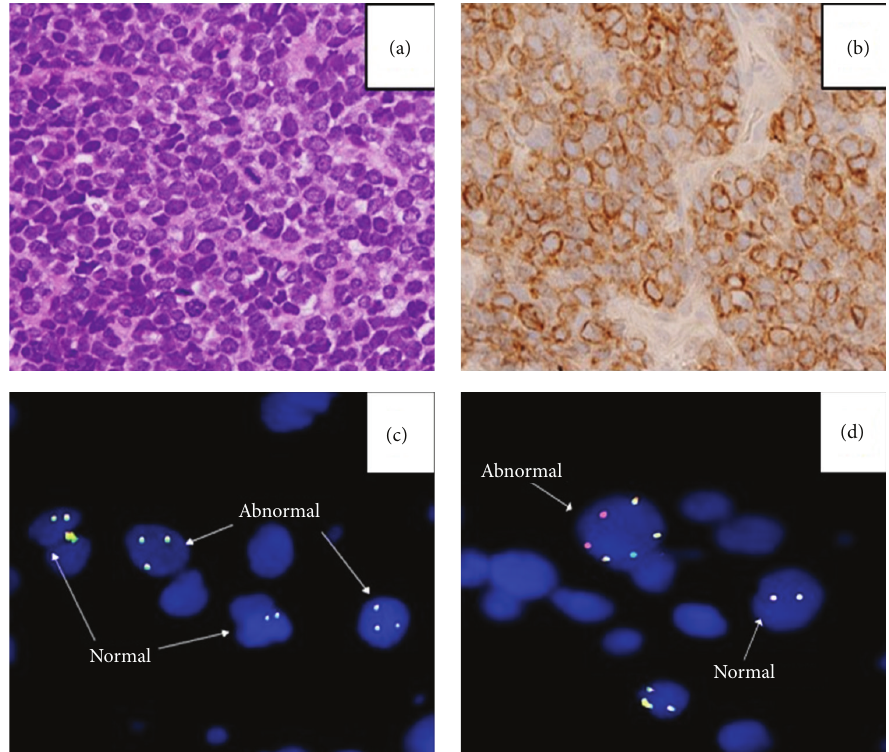
Figure 1: H&E staining demonstrating large B cells (a) positive for CD20 (b). FISH studies showing IGH-MYC translocation (c), dual color, dual fusion translocation probe identifying IGH and BCL2 gene rearrangements